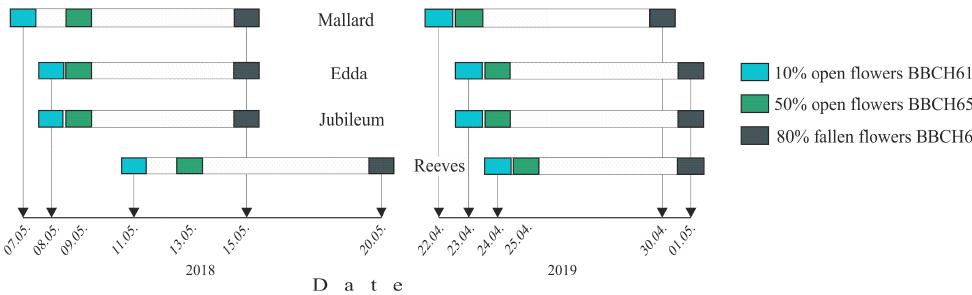
Figure 3. Flowering periods of plum cultivars in 2018 and 2019.